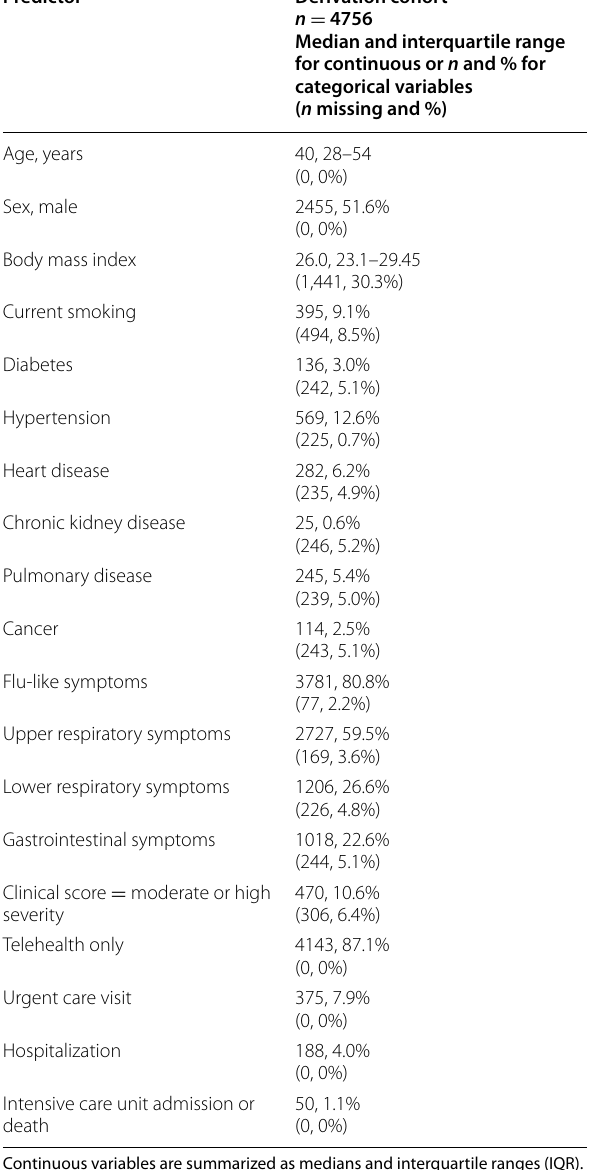
Table 1 Variables included in the prognostic model are shown for the derivation